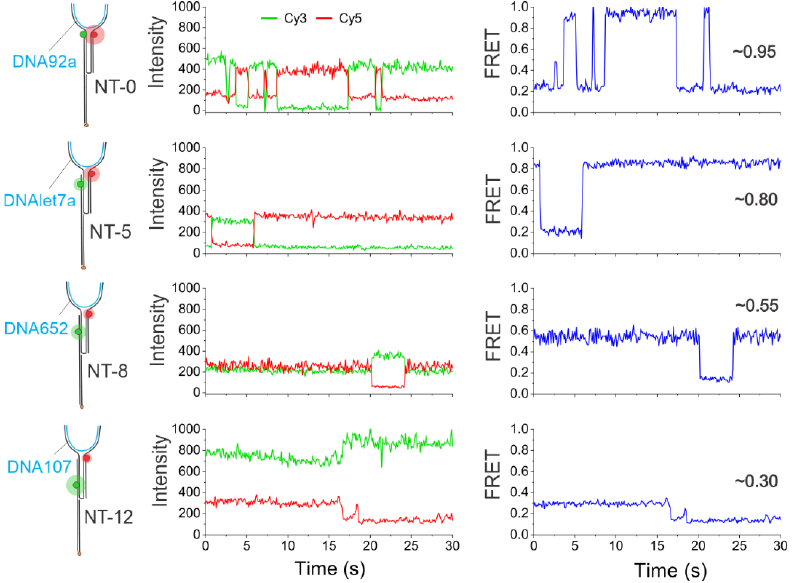
Figure 3. Representative intensity-time and E FRET -time traces showing either static or dynamic behaviors for each sensor (schematics shown on the left). The red and green spheres represent Cy5 and Cy3 fluorophores respectively and the blue lines represent the DNA targets. Distinctly different FRET efficiency values were observed for each NT sensor immobilized individually on the microscope slide. Specifically, NT-0, NT-5, NT-8, and NT-12 showed FRET efficiency values of ~0.95, ~0.8, ~0.55, and ~0.30, respectively. The target was added at 100 pM in all experiments. Each sensor was characterized individually.